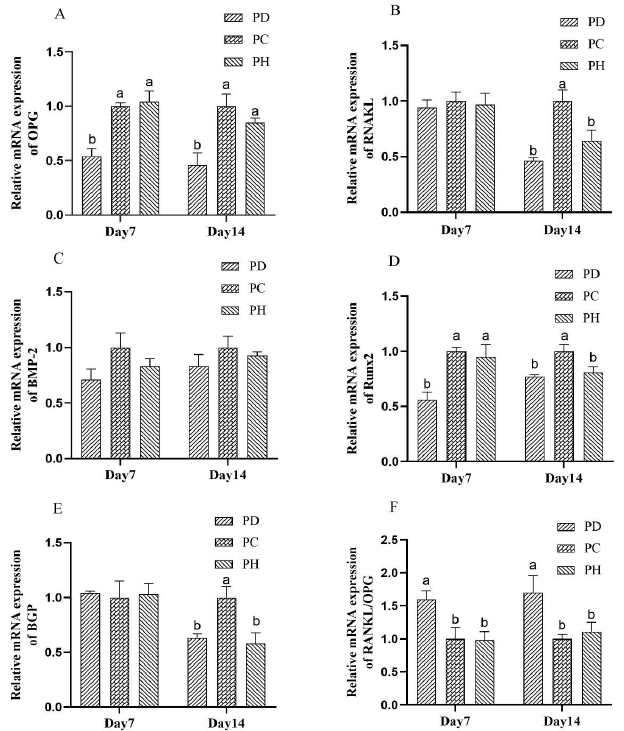
Figure 2. Effects of dietary phosphorus (P) deficiency and high P content on the mRNA relative expression of osteogenesis in the cartilage of the tibia of goslings. a,b Values within a row without common superscripts differ significantly ( p < 0.05). Abbreviated letters in the figure: The goslings were fed, respectively, with P deficiency (PD) diet, P control (PC) diet, and a high P content (PH) diet; ( A ) OPG (osteoprotegerin); ( B ) RNAKL (receptor activator of NF- κB ligand); ( C ) Runx2 (runt-related transcription factor 2); ( D ) BMP-2 (bone morphogenetic protein 2); ( E ) BGP (bone Gla-protein); ( F ) RNAKL:OPG ratio.